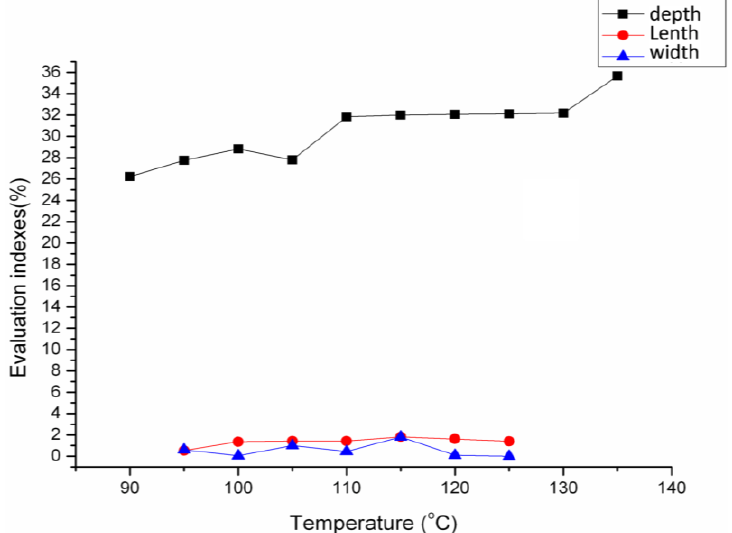
Figure 7. The relationship between temperature and evaluation indexes.